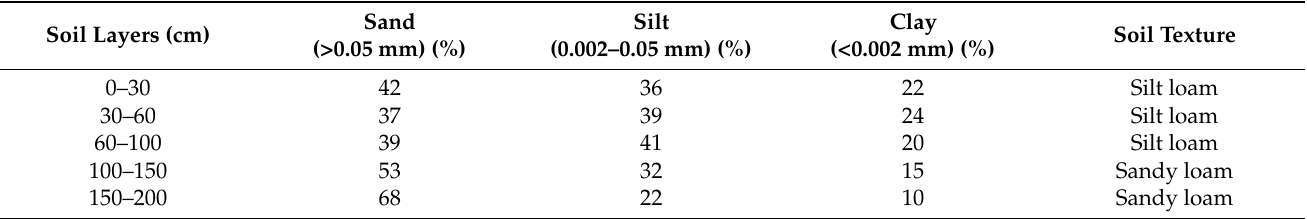
Table 1. Soil physical properties at the Xuchang experiment station before the field experiment started in